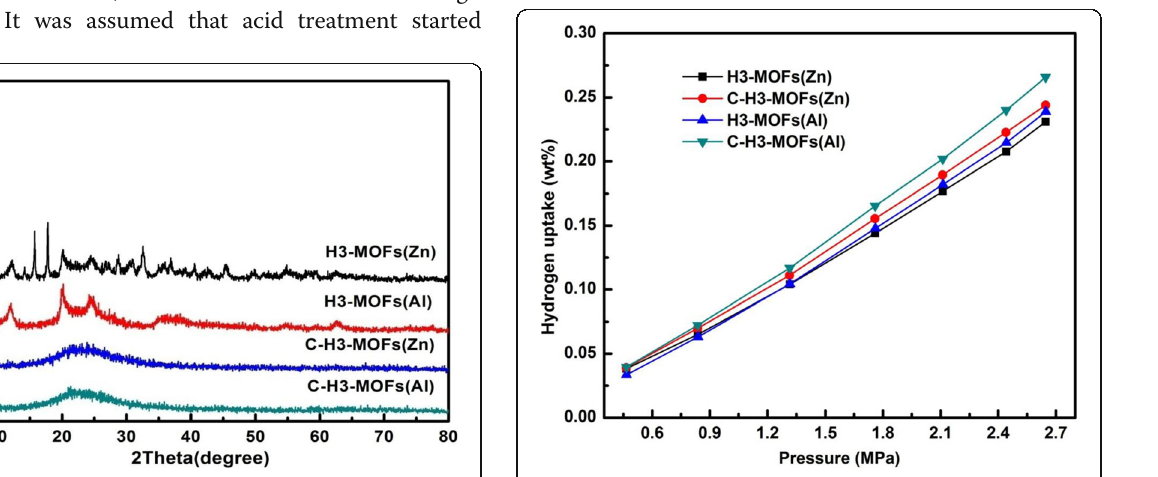
Fig. 3 Hydrogen adsorption isotherms of H3-MOFs(Zn), H3-MOFs(Al), C-H3-MOFs(Zn), and C-H3-MOFs(Al)